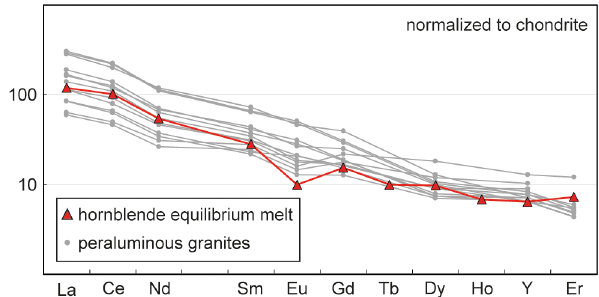
Figure 12. Calculated chondrite-normalized (Anders and Ebihara, 1982) REE and Y compositions of melt in equilibrium with horn- blende from fine-grained amphibolite PN2. The amphibole–melt partition coefficients determined experimentally for a melt having SiO 2 = 63 . 9wt% were used (Nandedkar et al., 2016). Amp/Liq D values are La = 0.329, Ce = 0.714, Nd = 2.334, Sm = 4.19, Eu = 5.052, Gd = 5.43, Tb = 6.062, Dy = 6.041, Ho = 6.46, Y = 6.113 and Er = 5.97. Whole-rock composition of late-Variscan peraluminous granites (Rottura et al., 1993; Fiannacca et al., 2019) are reported for comparative